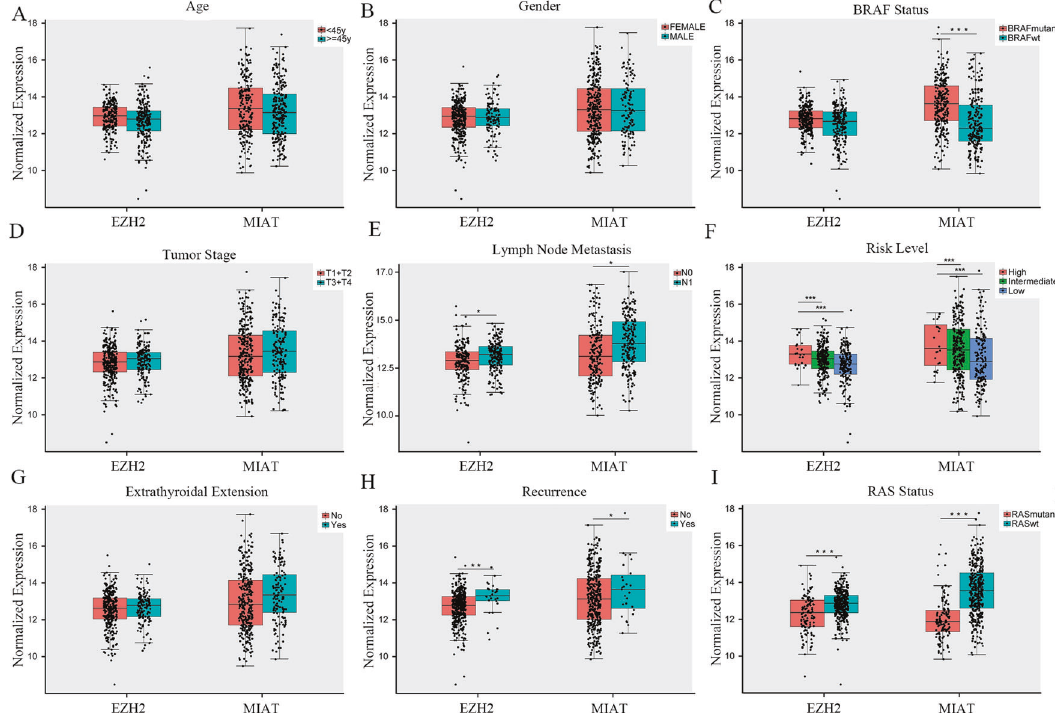
Fig. 5 Association between lncRNA-MIAT and EZH2 expression and clinicopathological features in PTC. Signi fi cance differences in lncRNA- MIAT and EZH2 expression were found among various clinicopathological features, including age ( A ), gender ( B ), BRAF status (mutation vs. wild type) ( C ), tumor stage (T1 + T2 vs. T3 + T4) ( D ), lymph node metastasis (no vs. yes) ( E ), risk level (high vs. intermediate vs. low) ( F ), extrathyroidal extension (no vs. yes) ( G ), recurrence (no vs. yes) ( H ), and RAS status (mutation vs. wild type) ( I ). The X axis indicates lncRNA- MIAT and EZH2, the Y axis indicates normalized expression. The plots were created using the ggplot2 package of R. * P < 0.05, ** P < 0.01, *** P < 0.001 compared with control cells, n.s. non-signi fi cant, using two-tailed t -test analysis. Cell Death and Disease (2021)